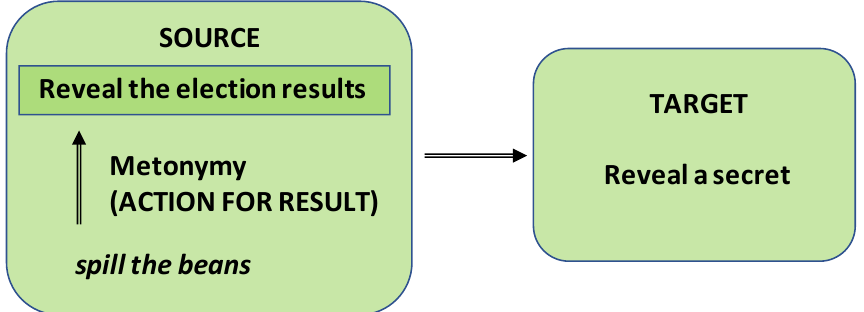
Figure 4. Metonymic expansion of the metaphoric source underlying the interpretation of ‘spill the beans.’